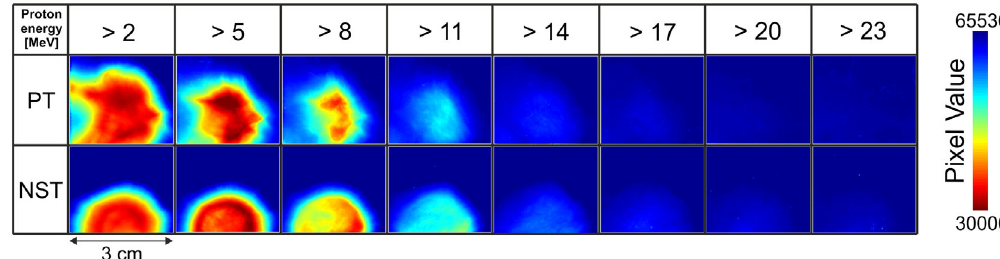
FIG. 3. Proton beam profile using red color channel for PT and NST targets obtained from the RCF